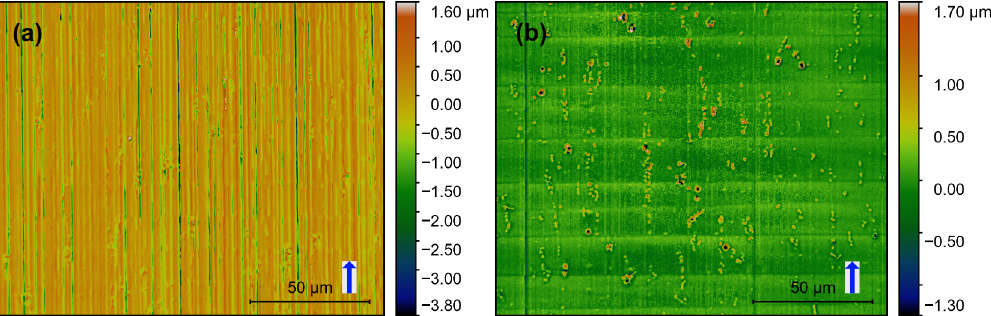
Figure 9. Confocal images of AA6082 surfaces milled with f z = 8µm: ( a ) SC-tool, ( b ) MD-tool.